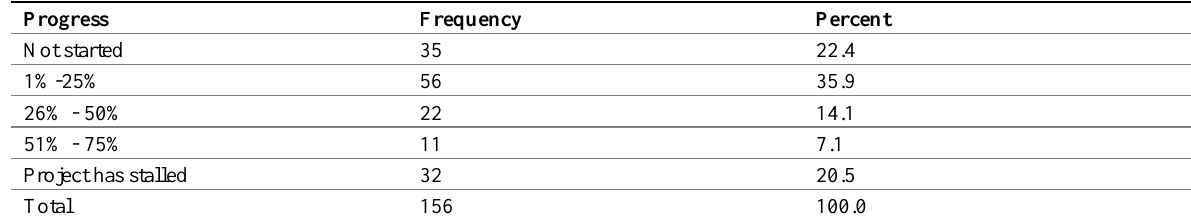
Table 4 : Progress of Incomplete Projects